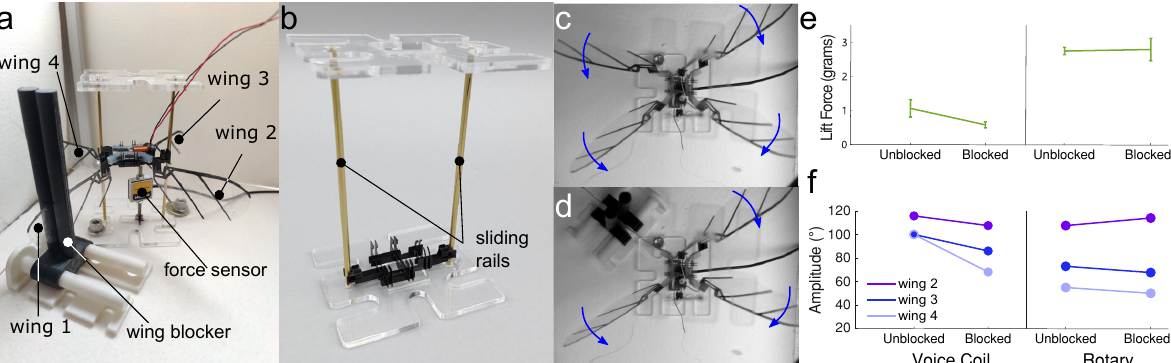
Figure 11. Overview of robustness test. ( a ) Detail of measurement setup with wings and wing blocker labeled. ( b ) The brass sliding rails on either side of the chassis restrict motion to vertical, reducing anomalous force sensor measurements. The underactuated design of the transmission means that flapping is possible even when one wing is restricted ( c , d ). ( e ) Lift can be produced even when a wing is blocked, although the rotary motor performed better than the voice coil motor. ( f ) Both voice coil and rotary designs maintained significant wingbeat amplitudes, but fabrication inconsistencies made it difficult to achieve symmetrical